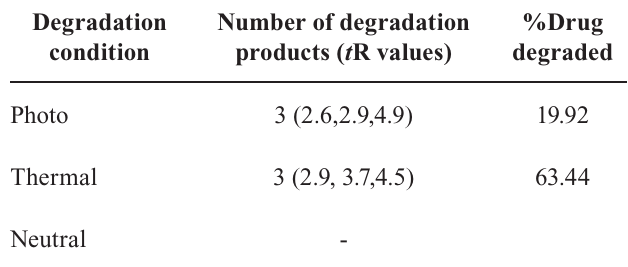
TABLE V - R esults of forced degradation studies